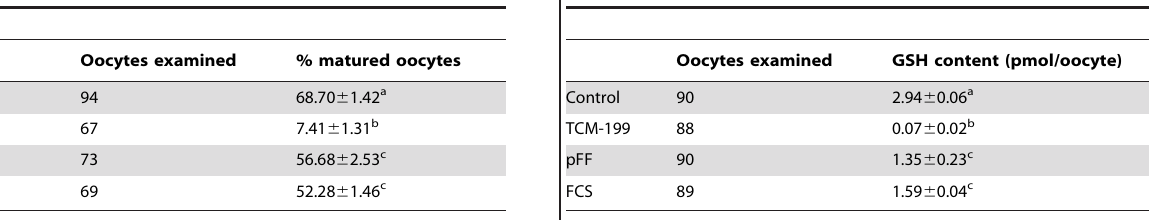
Table 4. Effects of different preservation media on GSH level after preservation at 27.5 u C for 3